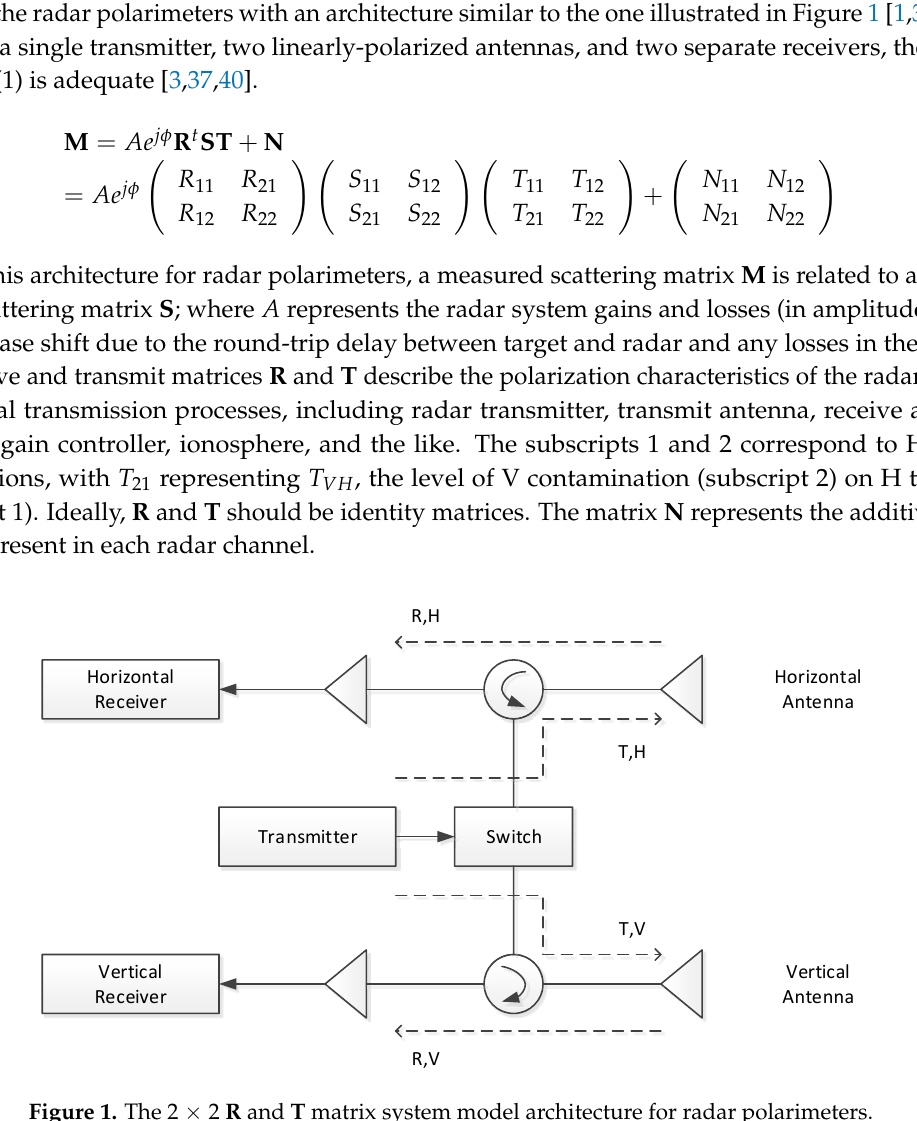
Figure 1. The 2 × 2 R and T matrix system model architecture for radar